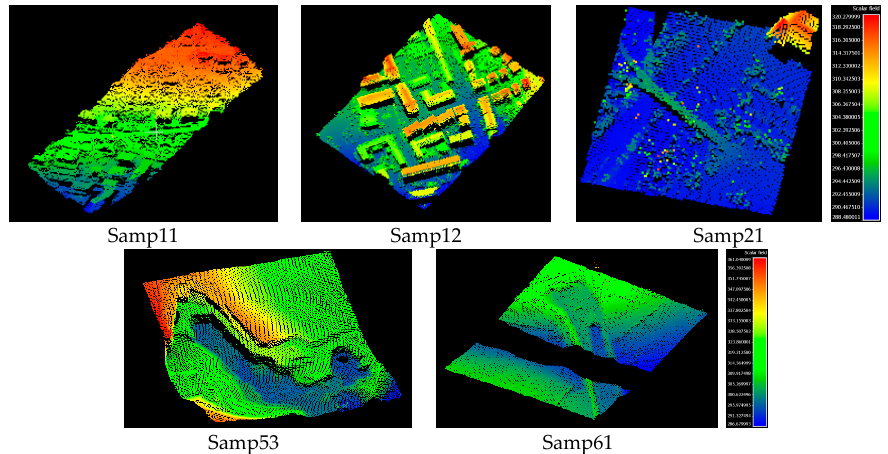
Figure 7. Five sample areas of the International Society for Photogrammetry and Remote Sensing (ISPRS) dataset chosen for the testing set.